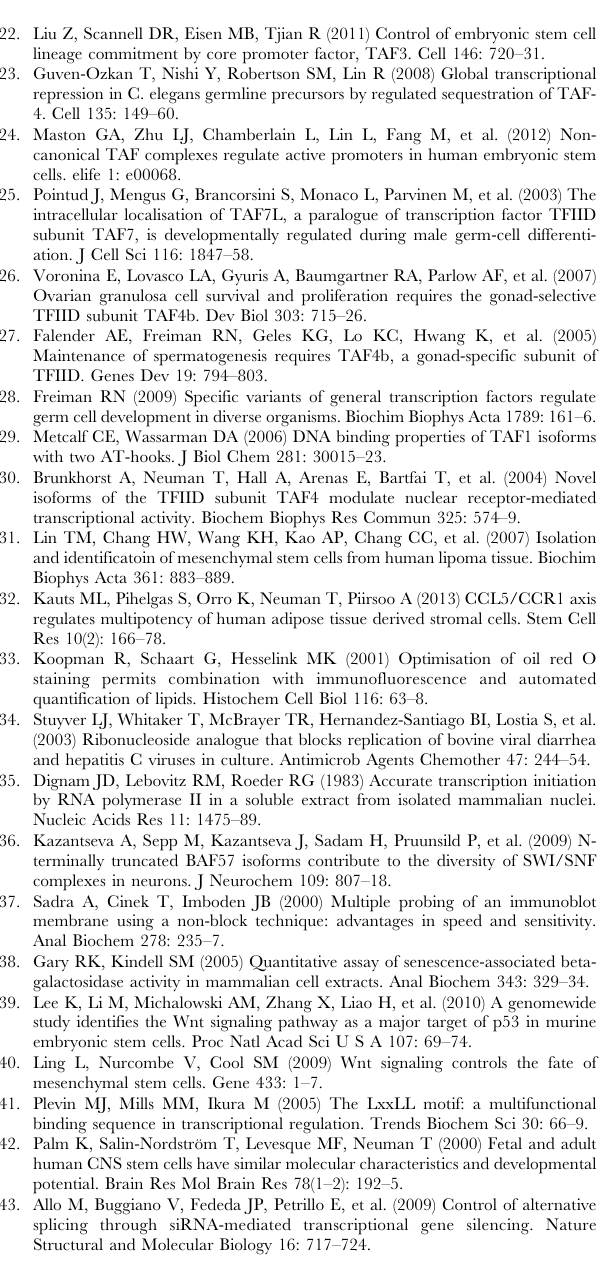
Table S1 Description of hMSCs clones used in the study.